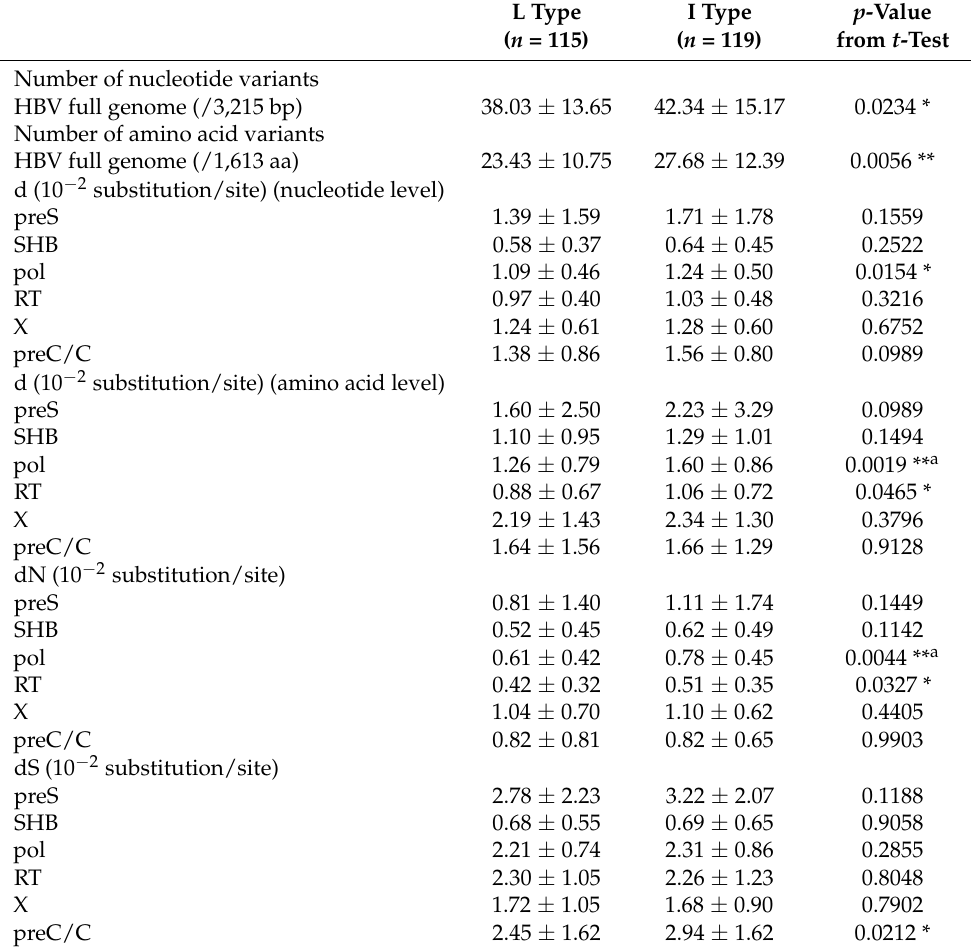
d, genetic distance; dS, the number of synonymous substitutions per synonymous site; dN, the number of non- synonymous substitutions per non-synonymous site; the significant values from t -test were shown in boldface and marked with asterisk (* p < 0.05, ** p < 0.01); a Statistically significant after Benjamini–Hochberg false discovery rate (FDR) ( a q <